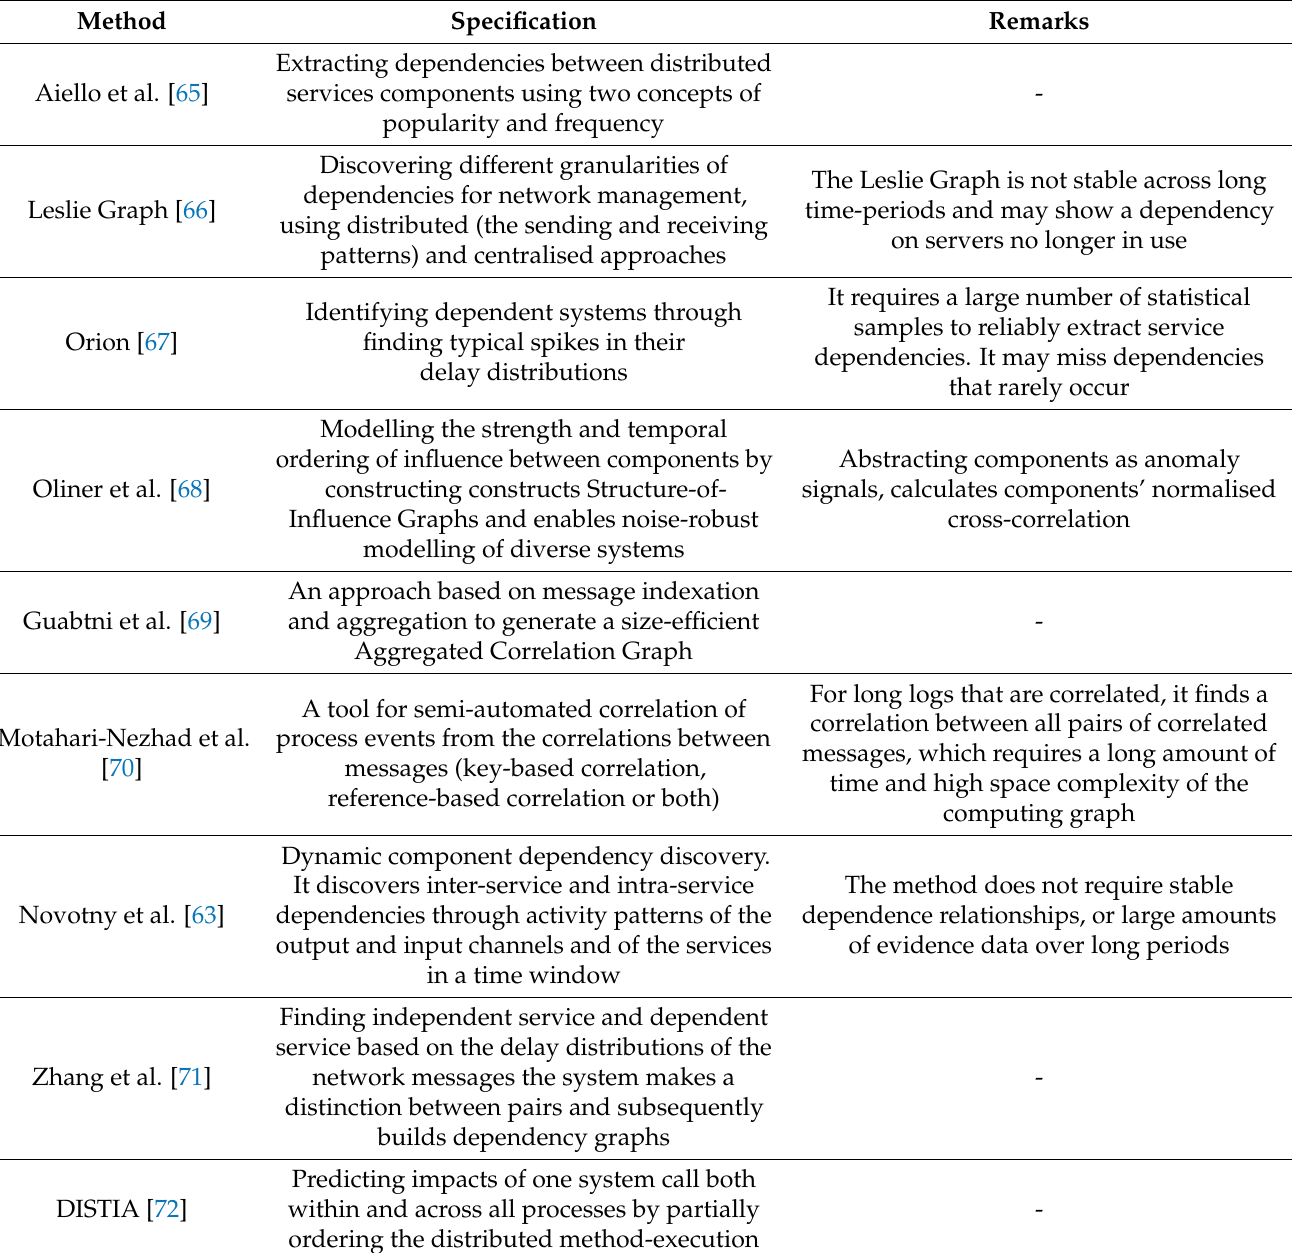
Table 6. Different approaches of multi-service dependency from Network